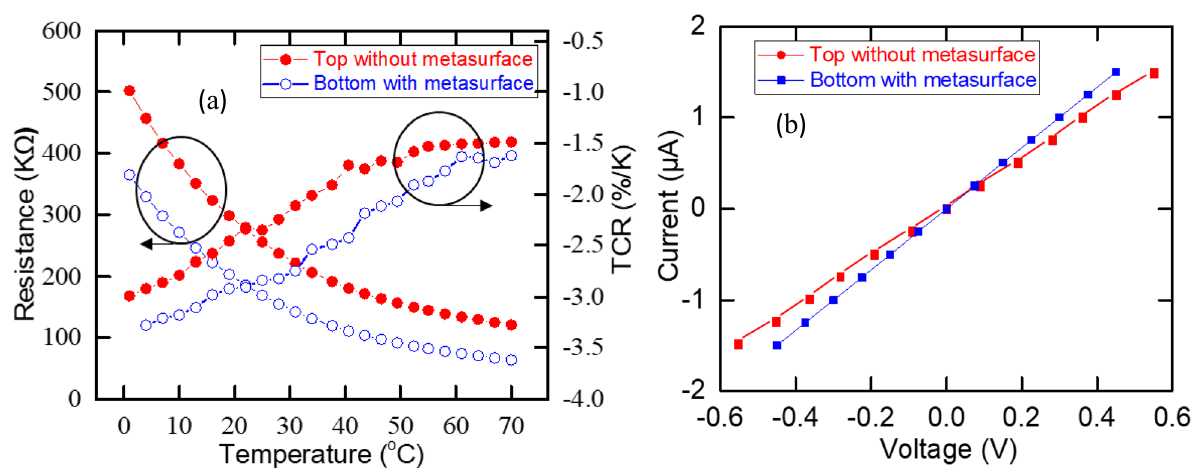
Figure 3. ( a ) TCR of the fabricated devices, and ( b ) Current–voltage characteristics of the fabricated device.